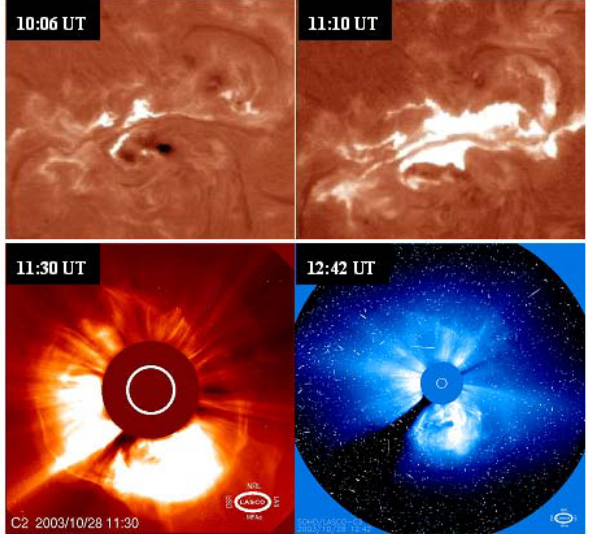
Fig. 1. The X17 class flare associated with a CME which led to a super-storm on 29 October 2003. The upper panels show a chro- mospheric image of the NOAA AR 10486 in H α , observed from Udaipur Solar Observatory on 28 October 2003. The lower two panels show the associated CME observed by LASCO-C2 and C3 coronagraphs aboard SoHO, in white